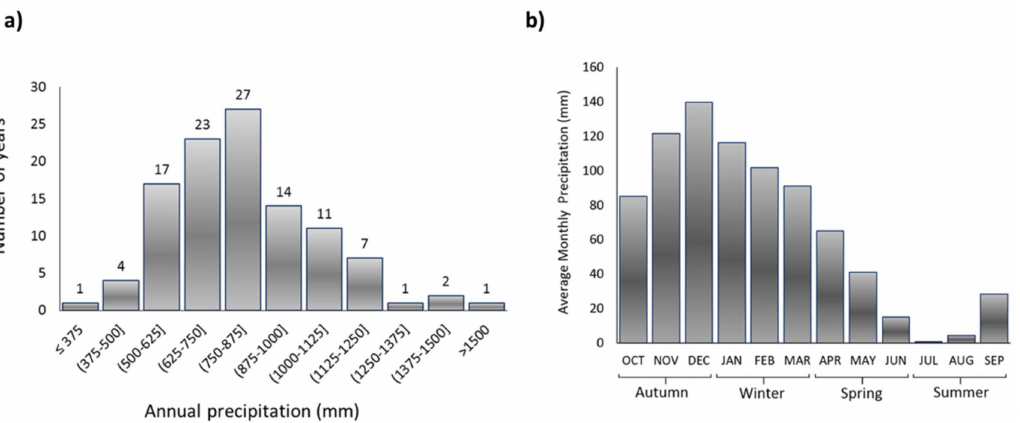
Figure 5. ( a ) Frequency distribution of the weighted mean annual precipitation; ( b ) average monthly precipitation with indication of its seasonal